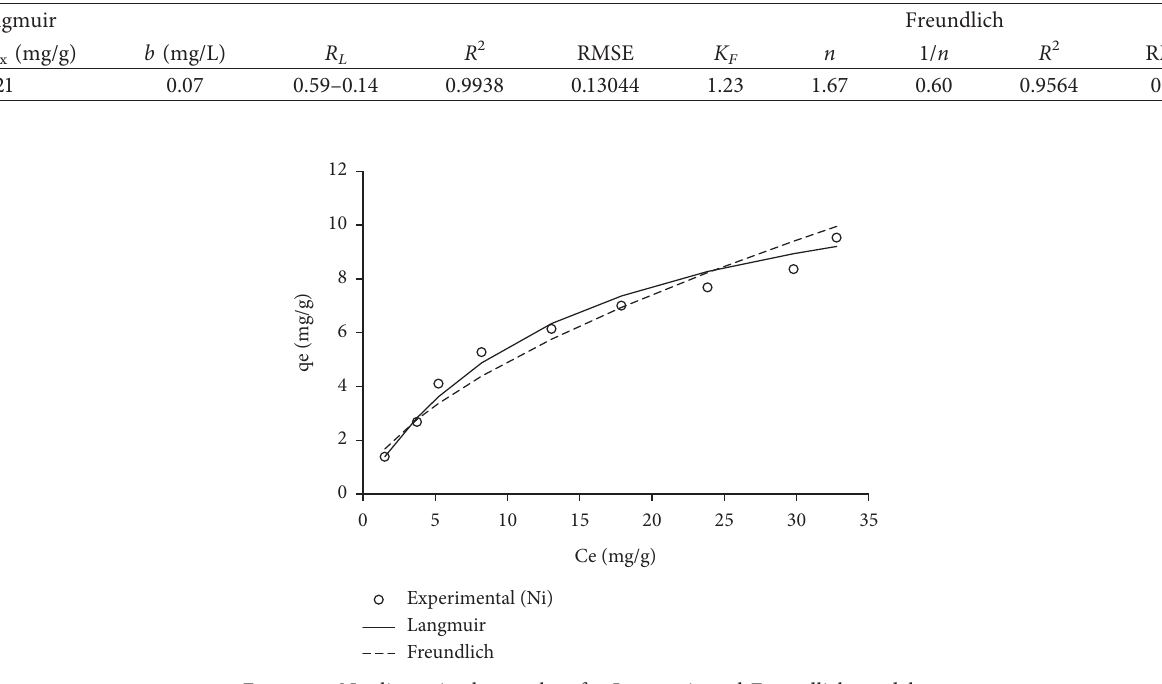
Table 3: Adsorption isotherms parameters for adsorption of GV onto HAB.